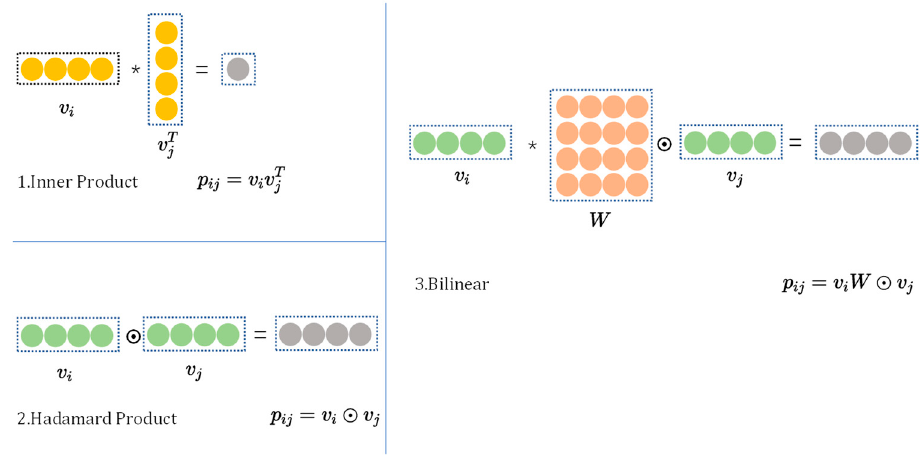
Figure 3. Three different types of interactions.